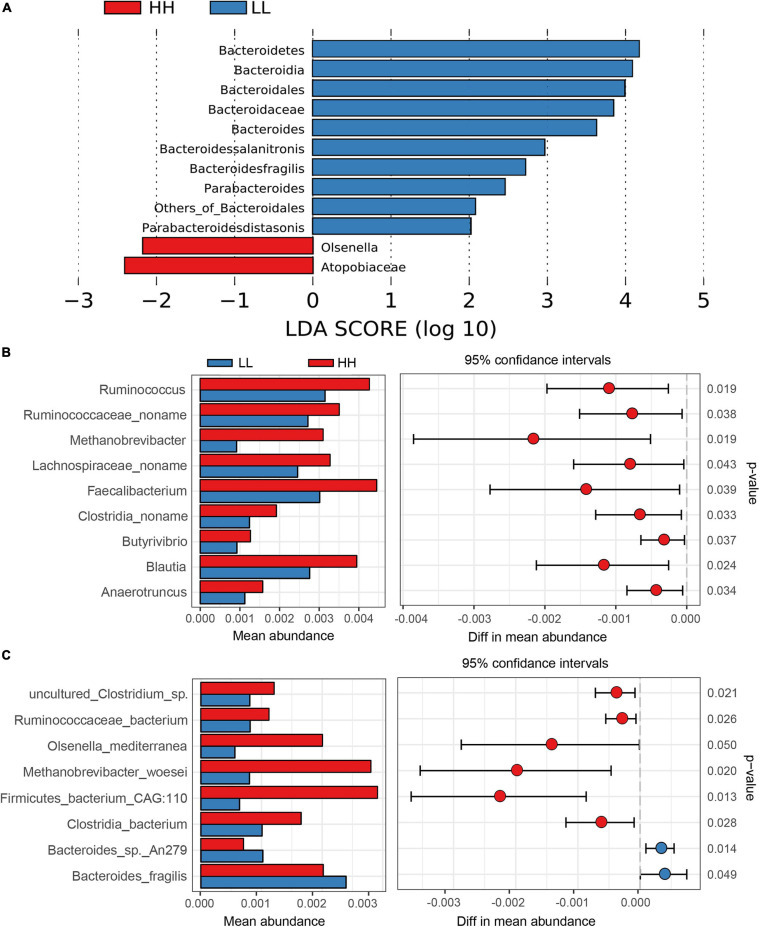
The taxonomic differences between high and low AFP chickens. (A) Differentially enriched gut microorganism identified by the LEfSe analysis of the taxonomic profiling based on the clean reads. (B) The differentially enriched gut microorganism genus based on gene annotation. (C) The differentially enriched gut microorganism species based on gene annotation. HH, high AFP chickens; LL, low AFP chickens.